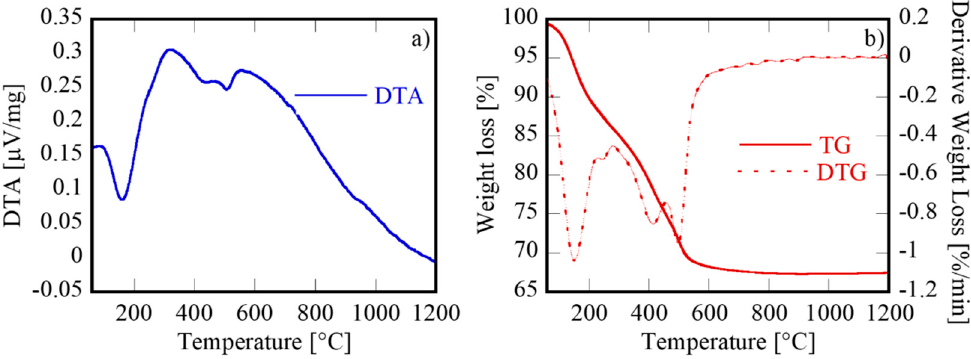
Figure 1. DTA ( a )-TG/DTG ( b ) of GPDC-AC.